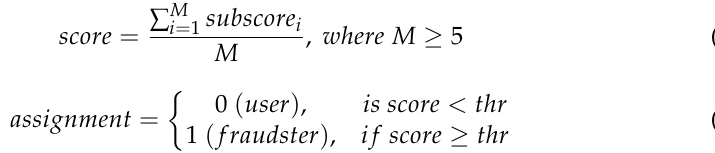
Figure 3. Exemplary user data on average accelerometer readings ( a ) and standard deviation of gyroscope readings ( b ) from 20-second intervals.